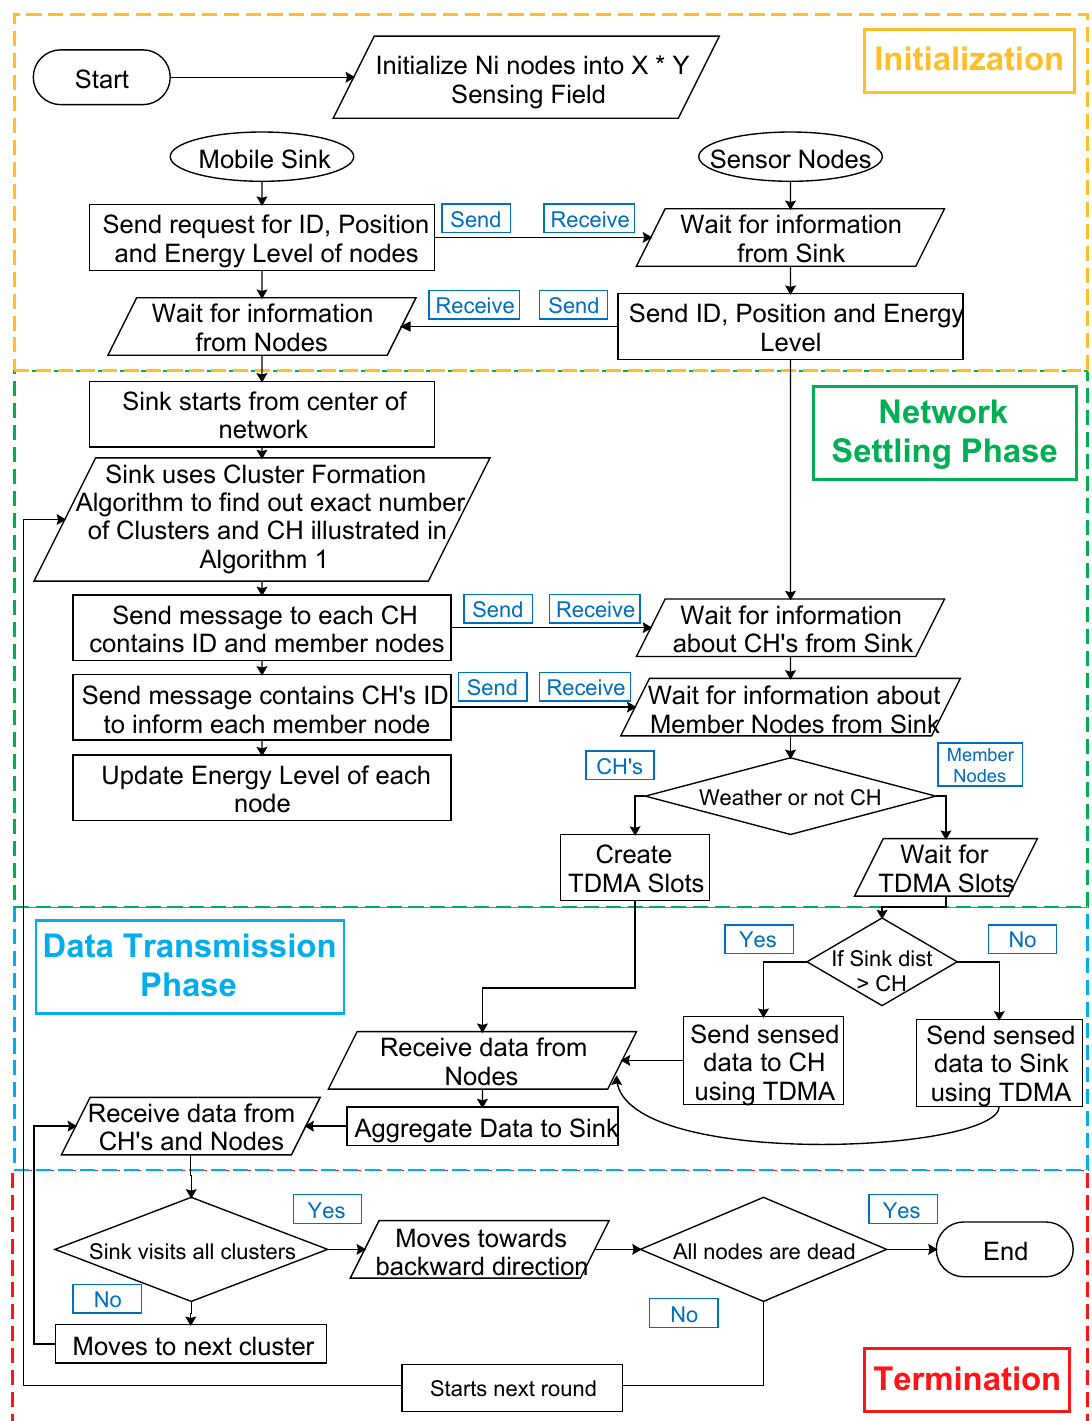
Figure 4. Flowchart of the proposed Spiral Mobility based on Optimized Clustering (SMOC) and Multiple sink-based SMOC (M-SMOC) routing